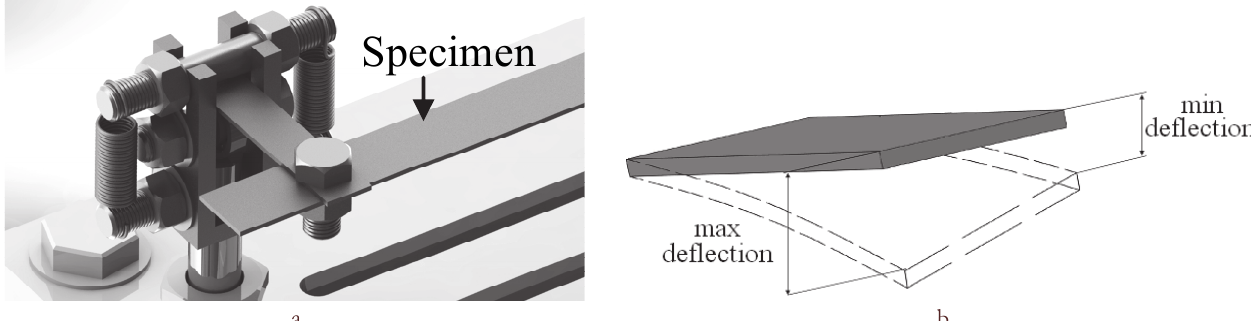
Figure 3: The scheme of the loading: a- specimen end fixed in the loading mechanism; b - scheme of combined deformation of the